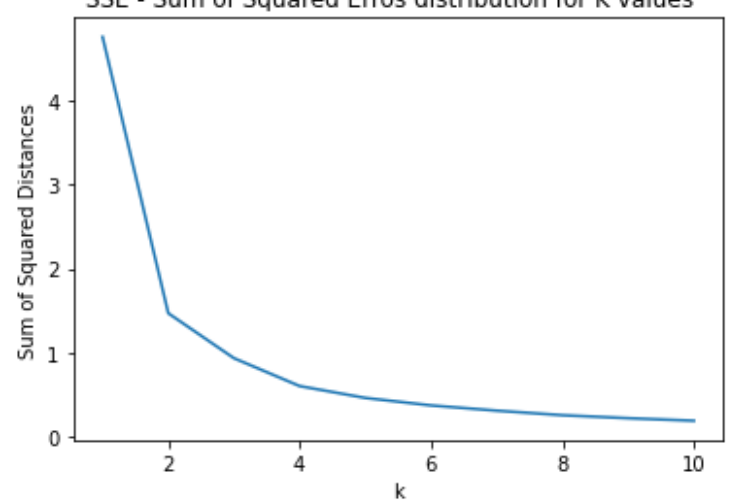
Figure 14. SSE variation according to K values in